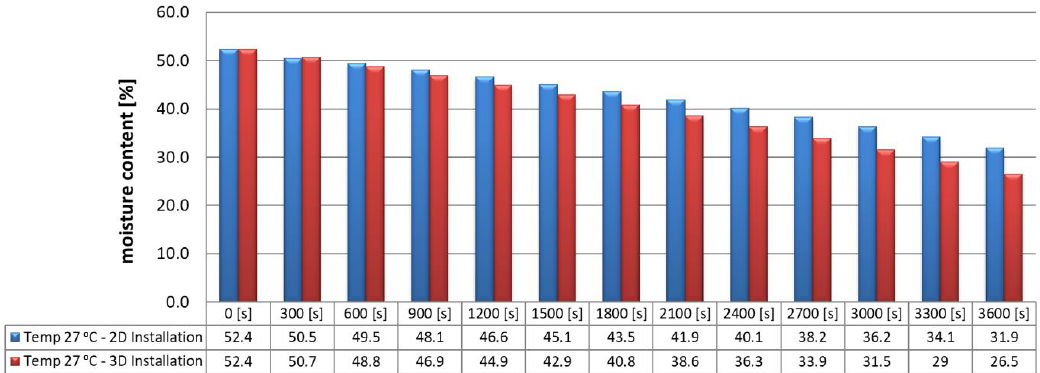
Figure 13. Influence of chamber geometry on coal drying process. The grain size was 0–8 mm, temperature 27 °C, Bełchatów coal.